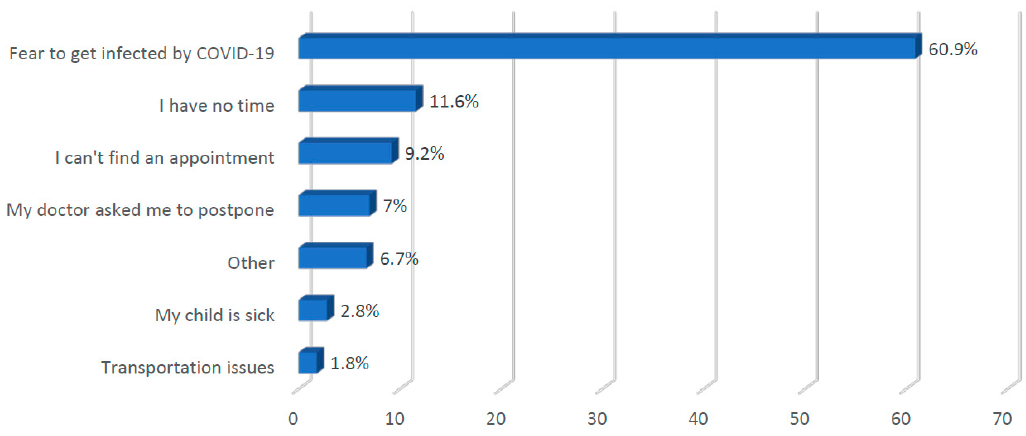
Figure 2. Reasons for vaccination delays.